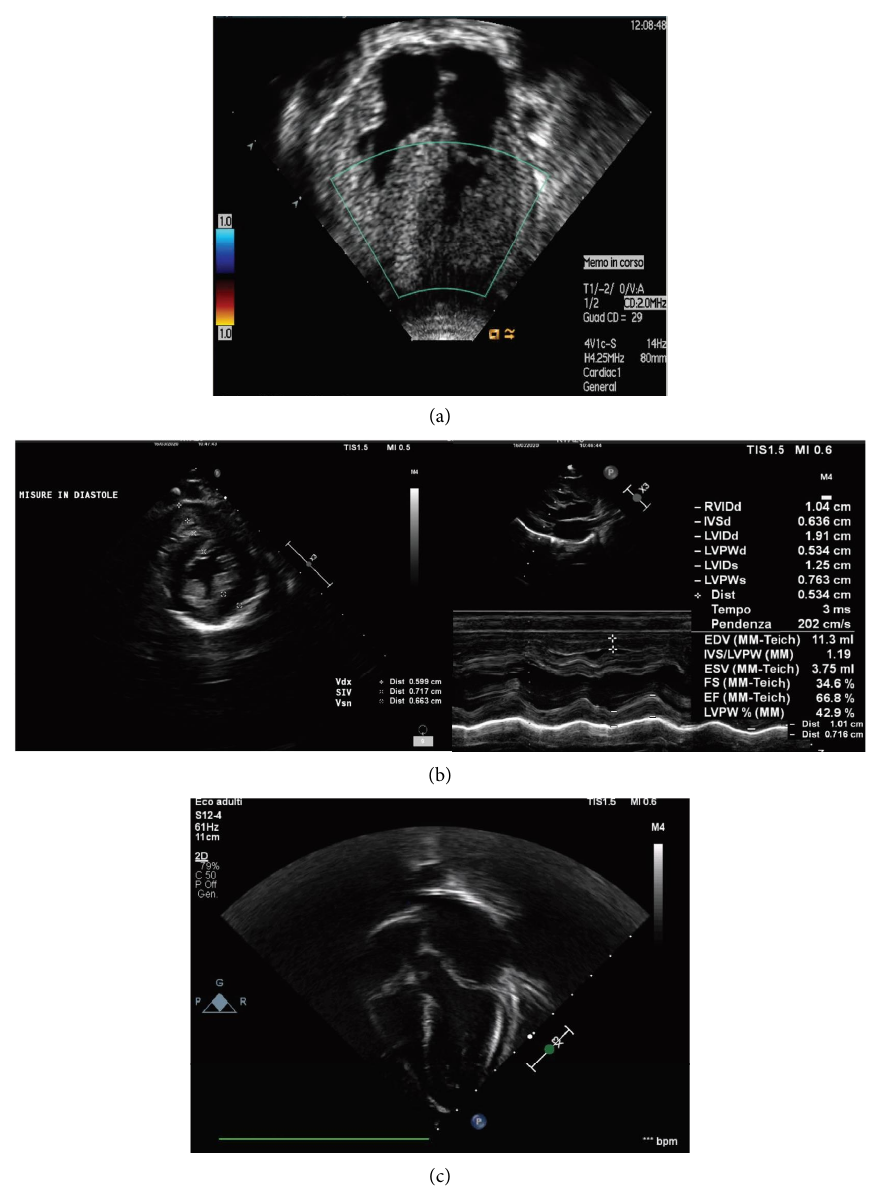
Figure 1: (a) Cardiac hypertrophy in a 6months patient (XX) with DGAA; (b) cardiac hypertrophy in an infant (XY) with DGAA; (c) regression of cardiac hypertrophy in patient (XY) after 15months of